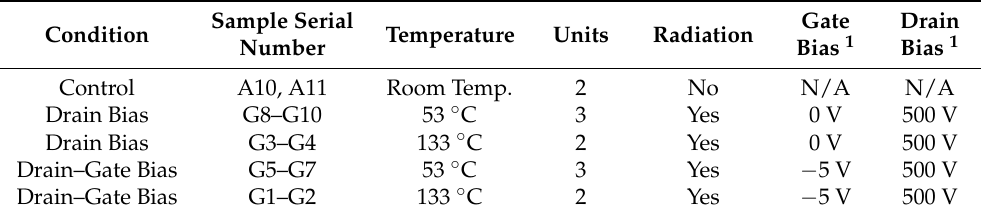
Table 1. Bias conditions that were applied during the irradiation